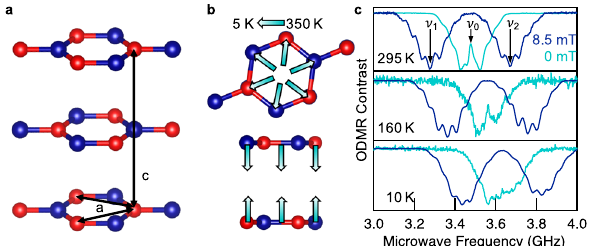
Fig. 1 Schematic of the hexagonal boron nitride (hBN). a Alternating boron (red) and nitrogen (blue) atoms and the lattice constants a and c . b Lattice contraction and expansion due to temperature variation, according to crystallographic data 24 . c cw ODMR spectra measured with (dark blue) and without (cyan) external magnetic fi eld at different temperatures T = 295, 160, and 10 K. Lowering of the temperature causes the resonances ν ; ν ν 0 1 and 2 to shift to larger microwave frequencies indicating an increase of the zero- fi eld splitting D gs